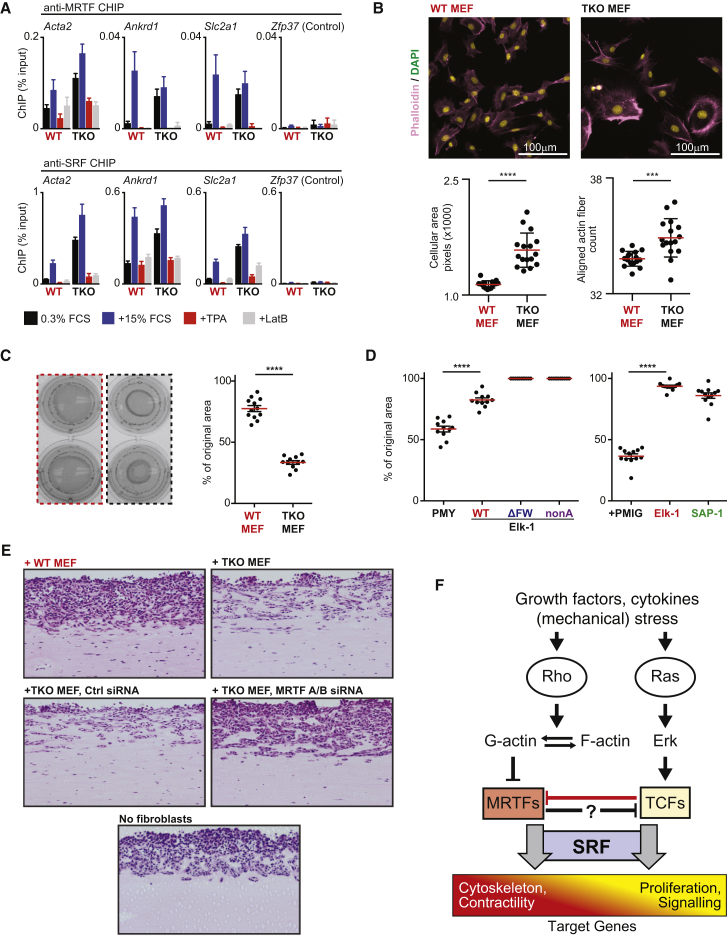
TCF Binding Directly Antagonizes MRTF-Dependent Gene Expression(A) Quantitative ChIP analysis of MRTF-A and SRF binding at regulatory elements of Acta2, Ankrd1, Slc2a1, and Zfp37 negative control in wild-type and TKO MEFs either resting (0.3% FCS, black) or treated with serum (30 min, blue), TPA (30 min, black), or Latrunculin-B (5 min, gray). Error bars show SEM (n = 4).(B) TKO MEFs are large and contain more aligned actin fibers. Cells were stained for F-actin (Phalloidin, magenta) and DNA (DAPI, blue), and the cellular area and aligned actin fibers were quantified (n = 16, >3,000 cells/condition). Read line, mean per set of replicates. (∗∗∗∗p < 0.0001, ∗∗∗p < 0.001, Mann-Whitney test).(C) TKO MEFs are highly contractile. Left: representative replicate gel contraction wells containing wild-type (red) or TKO (black) MEFs. Right: quantitation (n = 12; red bar, mean; ∗∗∗∗p < 0.0001; Mann-Whitney test).(D) TKO MEF hypercontractility is suppressed by expression of either wild-type Elk-1, its two transcriptionally inactive derivatives Elk-1FW and Elk-1nonA, or SAP-1. Quantitation is as in (C).(E) Representative images showing the invasion of 4T1 breast carcinoma cells into Matrigel containing no added fibroblasts, wild-type MEFs, or TKO MEFs with or without MRTF-A/B or control siRNAs.(F) Direct competition model for antagonism between MRTF-SRF- and TCF-SRF-dependent gene expression programs. Competition between the pathways for shared targets is indicated by diagonal shading.See also Figure S5.